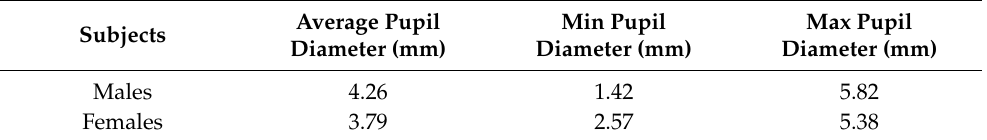
Table 5. Pupillary changes in subjects of different genders during complex task interaction. The pupil diameters of the different sexes were recorded during the experiment; we show the maximum, minimum, and mean values. The pupil diameter reflects the user’s eye fatigue and was therefore used as a